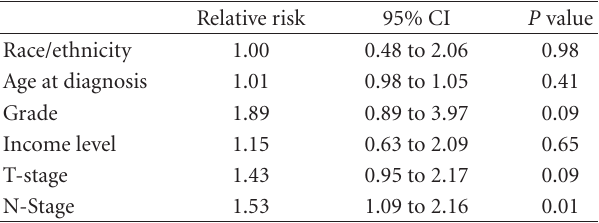
Table 3: E ff ect of race/ethnicity on overall survival for patients with triple-receptor negative breast cancer (Cox proportional hazard model).